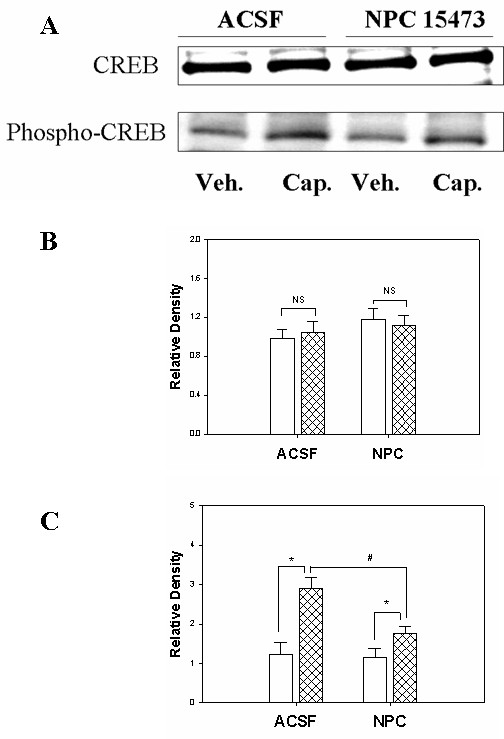
Expression of CREB and phosphorylated-CREB protein in spinal cord and the effect of intrathecal PKC inhibitor, NPC 15473, administration on their expression. Panel A. Western blot bands of CREB and phospho-CREB protein expression. Panel B. Bar graph showing the density of the immunoblot band of CREB protein. (NS, no significance between vehicle treatment vs. capsaicin treatment group with either ACSF- or NPC 15473- treatment). Panel C. Bar graph indicating the density of the immunoblotting band of phospho-CREB protein. (*, p < 0.05; the value from vehicle treatment vs. capsaicin treatment; #, p < 0.05, the value of ACSF-treated vs. NPC 15473-treated animals following capsaicin injection; n = 6 in each group). Open bar, vehicle group; hatched bar, capsaicin group.